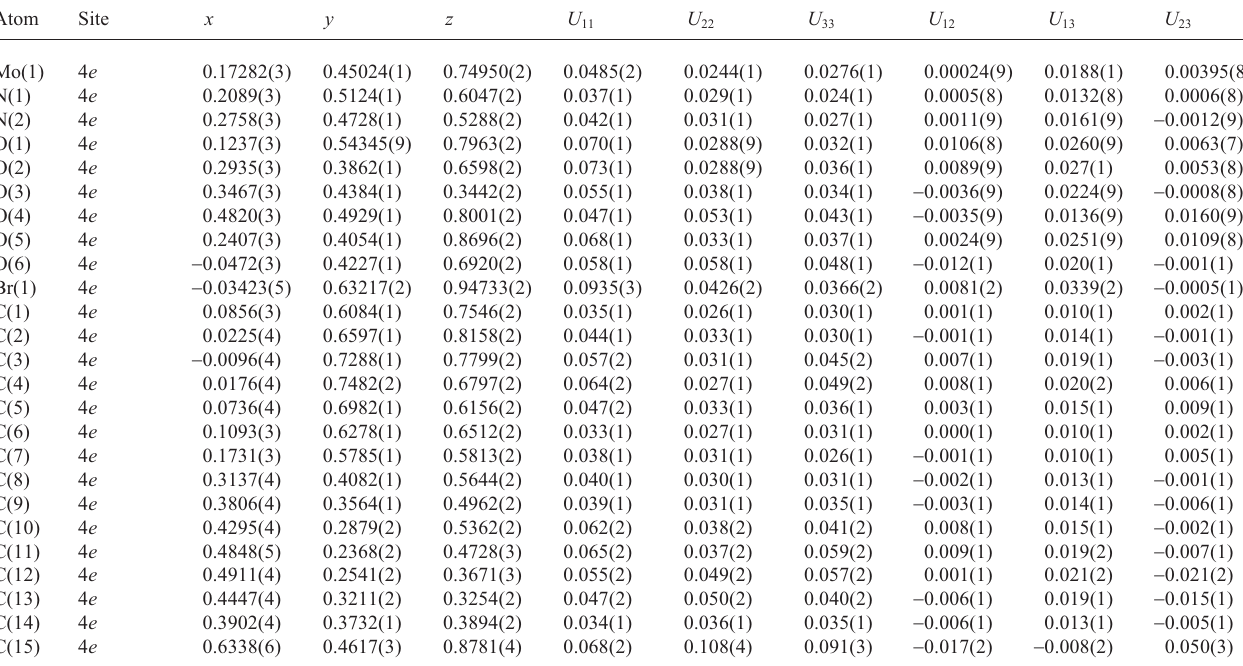
Table 3. Atomic coordinates and displacement parameters (in Å 2 )